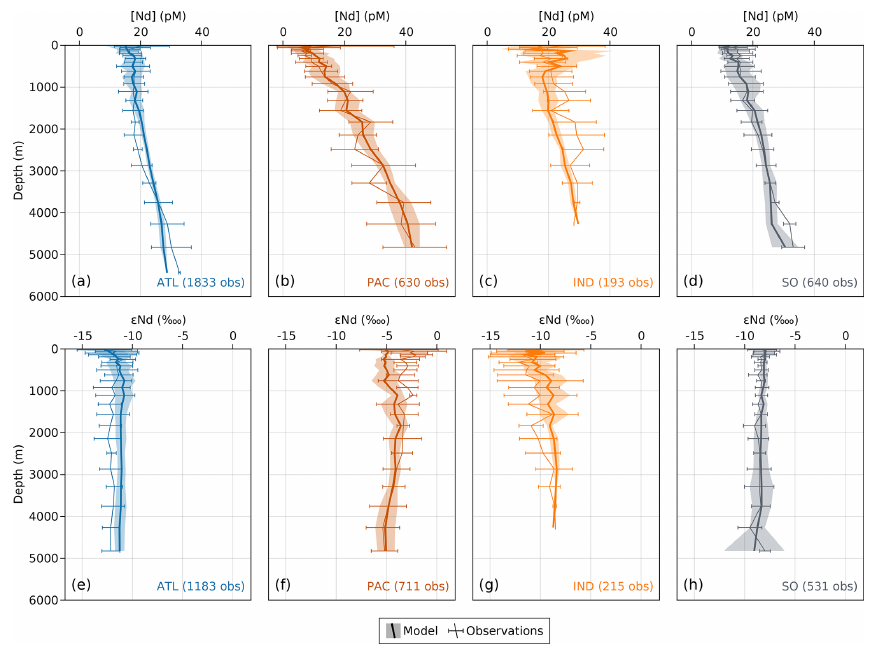
Figure 8. Basin-averaged profiles of (a–d) Nd concentrations and (e–f) ε Nd values versus depth. The basins (Atlantic, Pacific, Indian, and Southern Ocean) with the number of observations for each tracer are reported in the bottom right corner of each panel. The mean and standard deviation of observations are calculated at each vertical grid level of the OCIM v2.0 grid and represented by the thin line and error bars. The mean and standard deviation of the model are represented by the thick line and lighter-colored